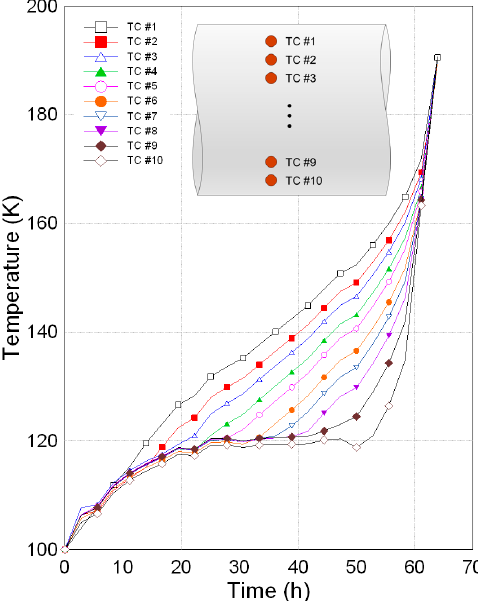
Figure 7. Time dependent temperature distributions of inner tank at each point.